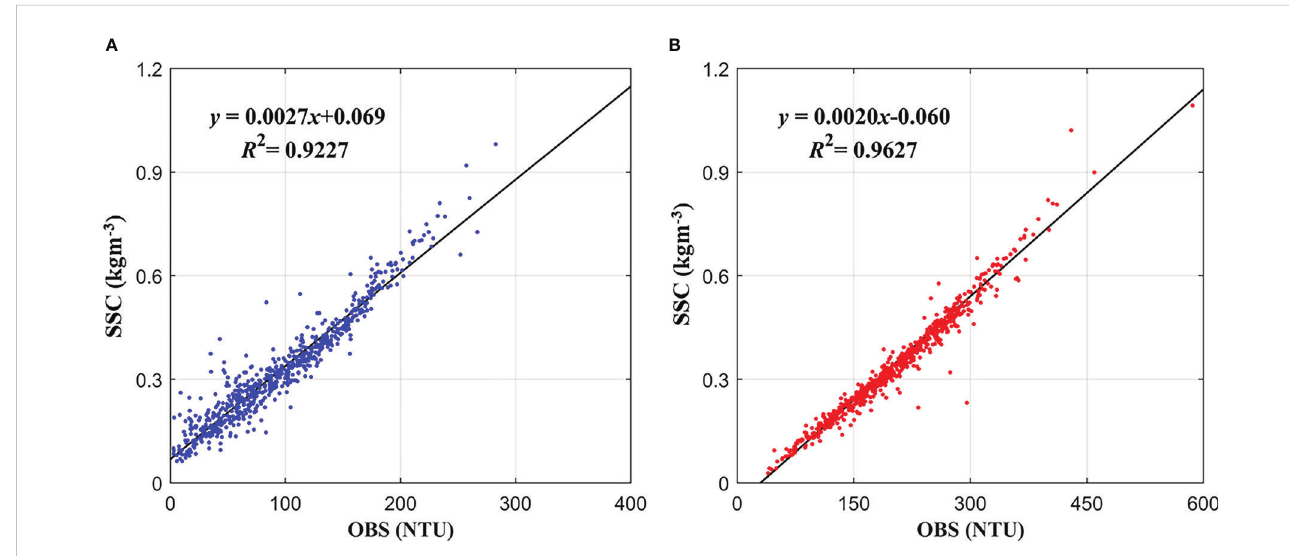
FIGURE 2 Calibration of the OBS data at station S1 (A) and station S2 (B)